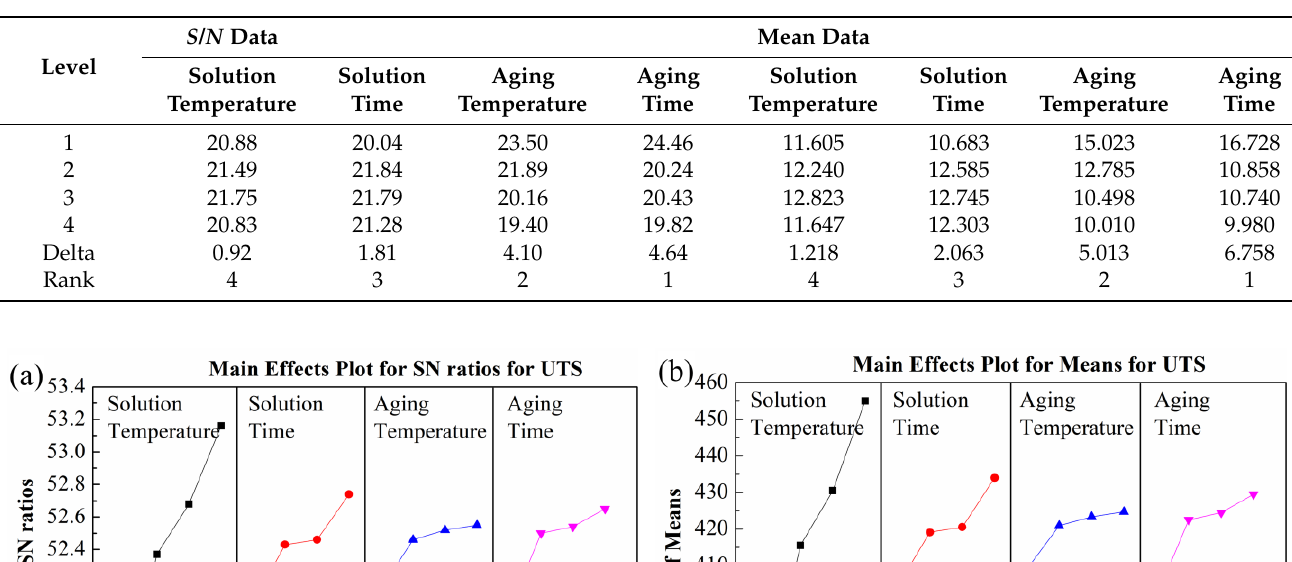
Table 7. Response table for signal-to-noise ratios (larger is better) and means for elongation.